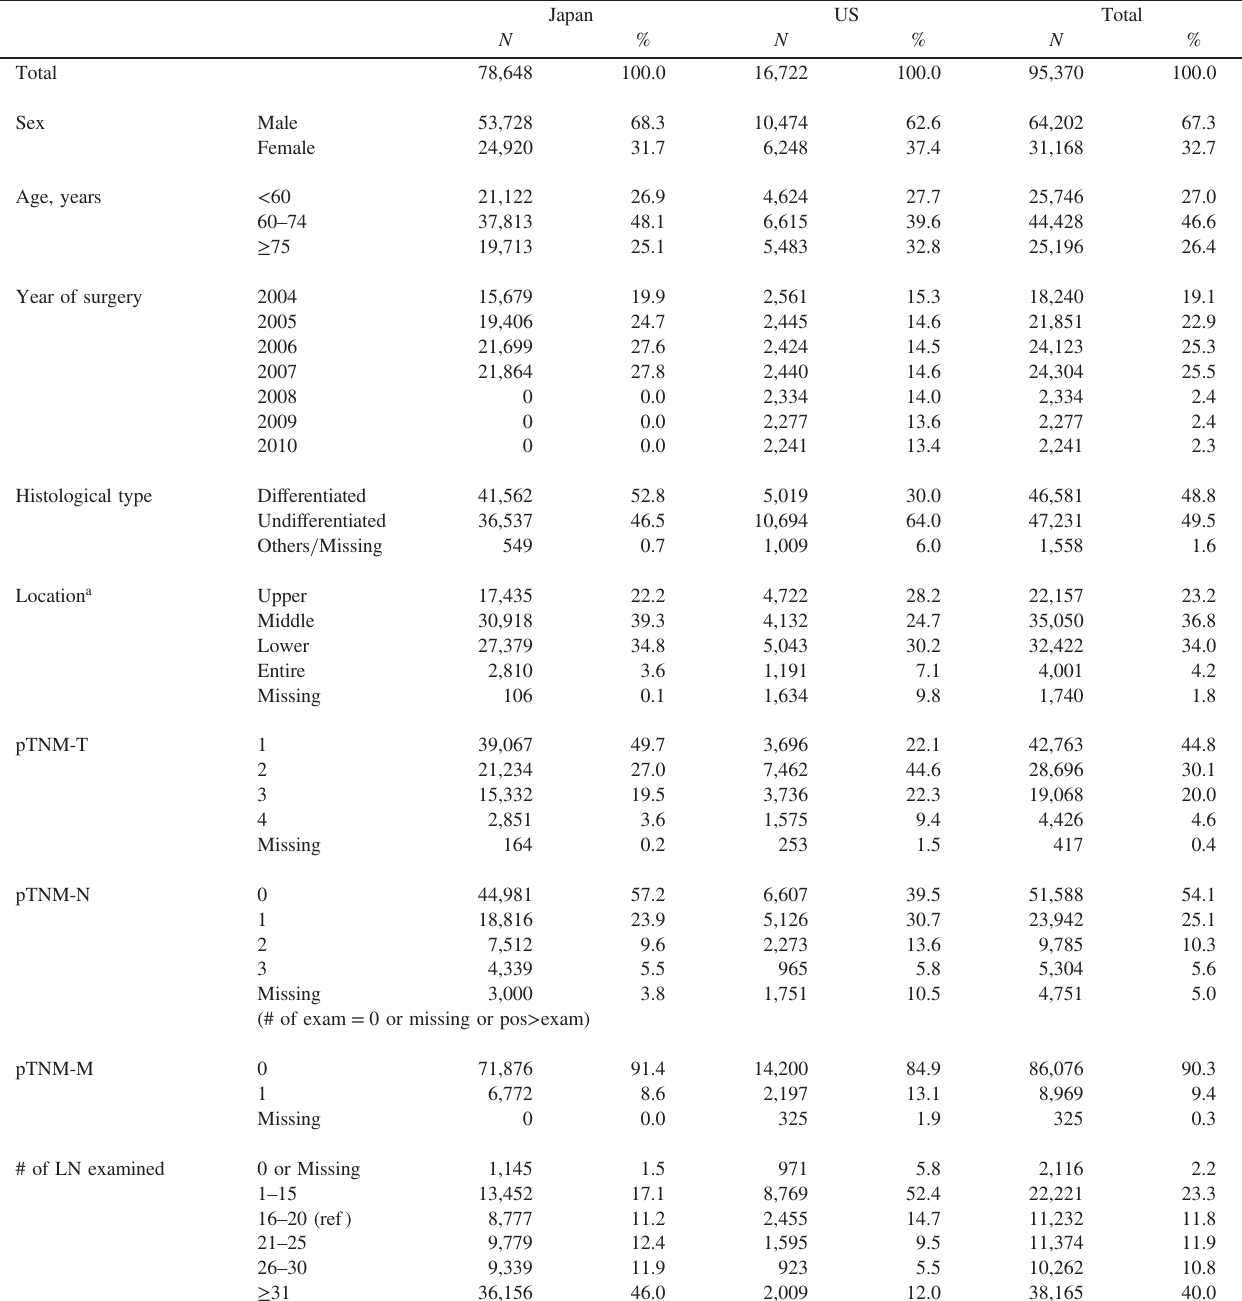
Table 1. Basic characteristics of analysed gastric cancer patients by country